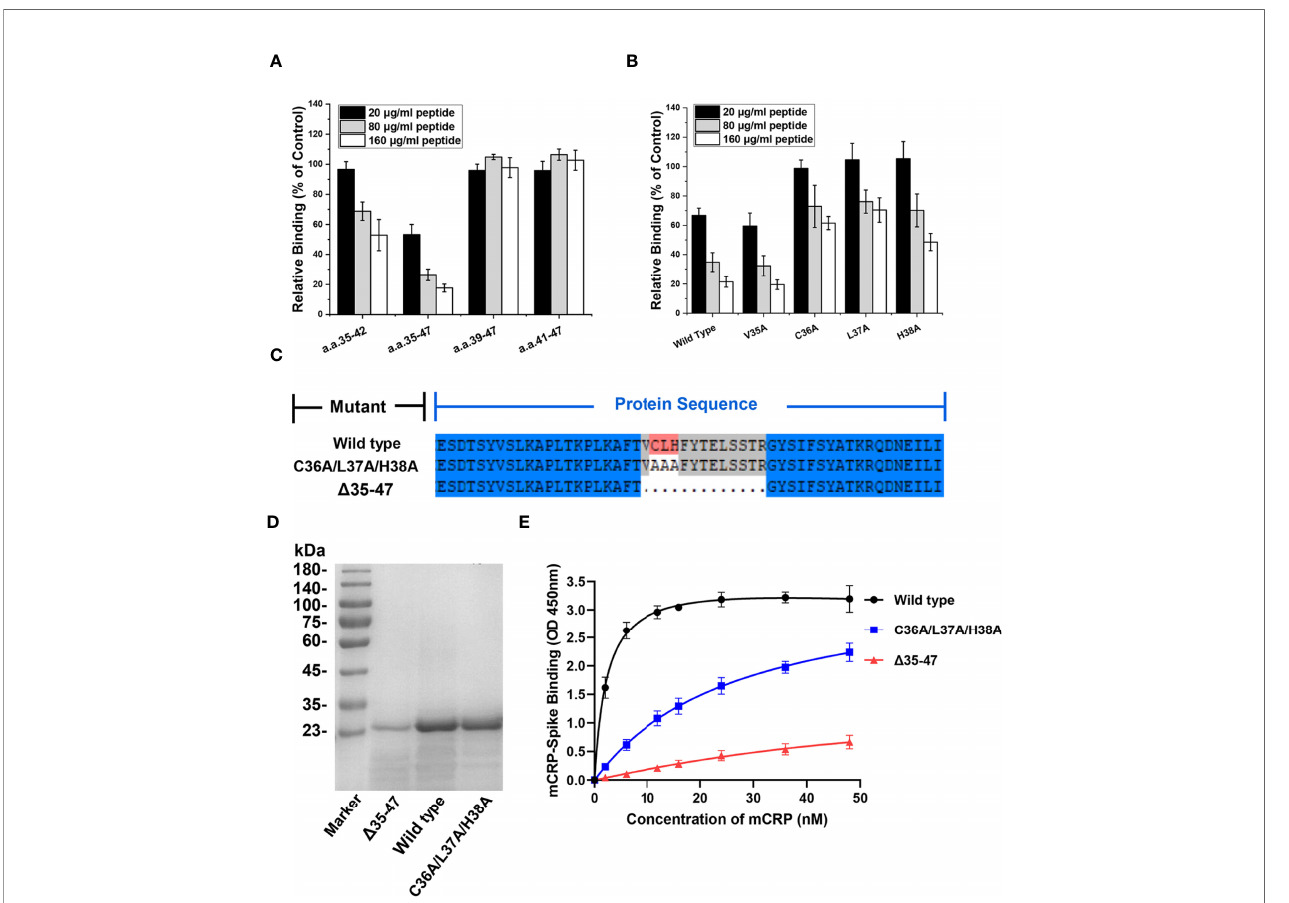
FIGURE 4 | The N-terminal residues determine the ligand-binding ability of the CBS. (A) CBS mutants with truncations in its N or C terminus were tested for their effects on mCRP binding to the spike RBD (n = 3). The inhibitory effects of CBS were lost following N-terminal truncation but not C-terminal truncation. (B) CBS with point mutations at the indicated N-terminal residues were tested for their effects on mCRP binding to the spike RBD. The three amino acid point mutations at the N- terminus (C36A/L37A/H38A) signi fi cantly weakened the ability of the CBS to compete for mCRP and spike RBD binding (n = 3). (C) Schematic showing construction of mCRP 35-47 amino acid deletion mutants ( D 35-47) and C36A/L37A/H38A mutants. (D) The wild type, C36A/L37A/H38A mutant, and D 35 – 47 mutants were constructed in E. coli and puri fi ed using SEC and SDS-PAGE. (E) mCRP wild type or mutants with altered CBS were expressed in E. coli and puri fi ed to test their binding to the spike RBD (n = 3). The binding of mCRP mutants was impaired by mutating the 3 N-terminal residues (C36A/L37A/H38A) or deleting amino acids 35 – 47. All results are presented as means ±